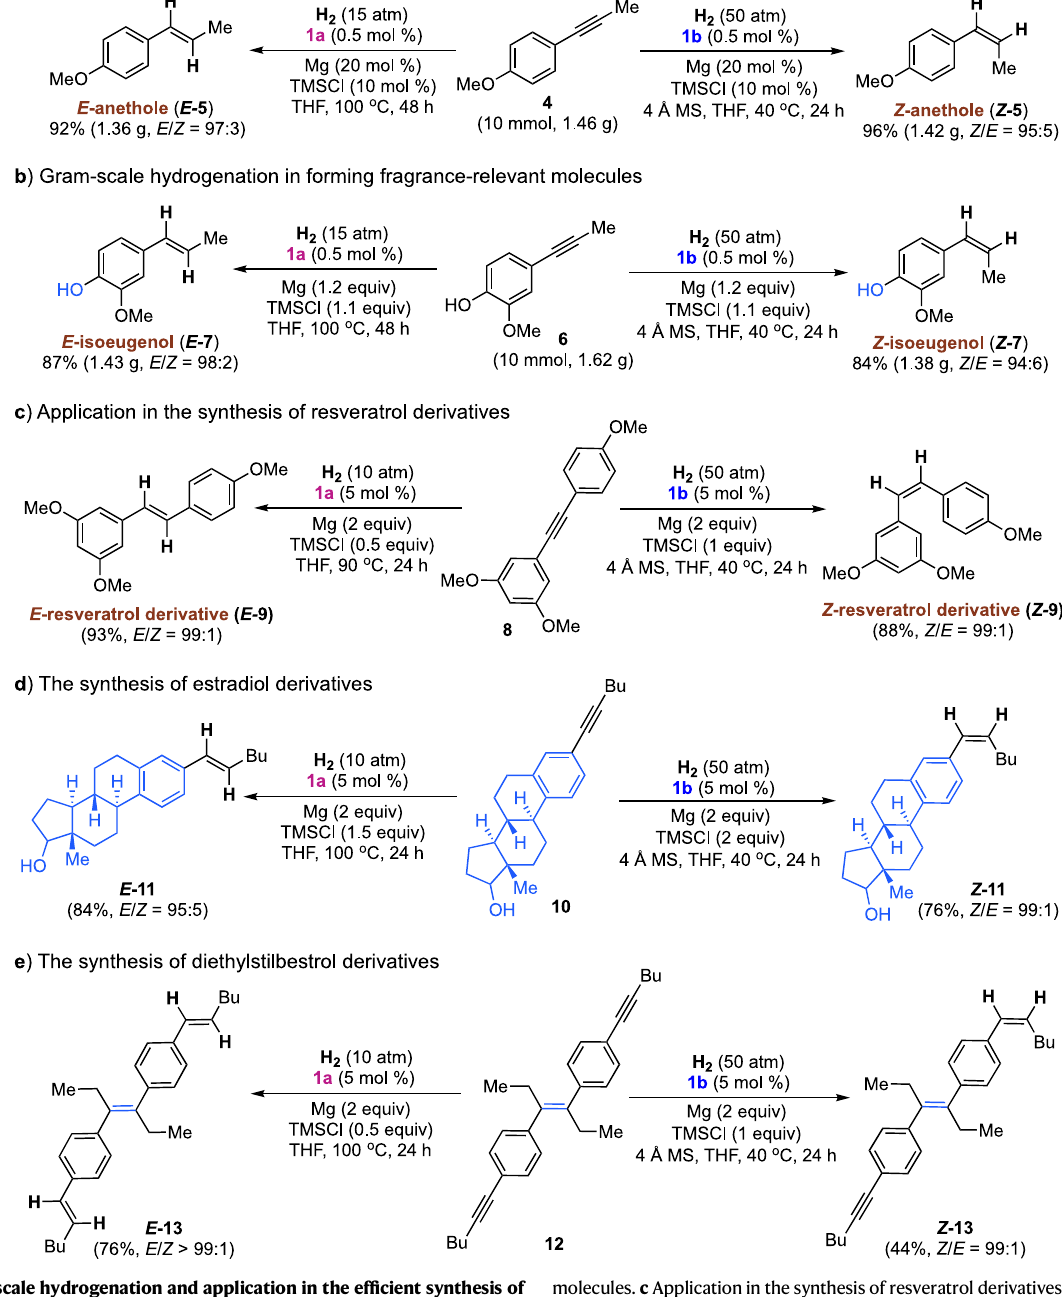
molecules. c Applicationinthesynthesisofresveratrolderivatives. d Thesynthesis of estradiol derivatives. e The synthesis of diethylstilbestrol